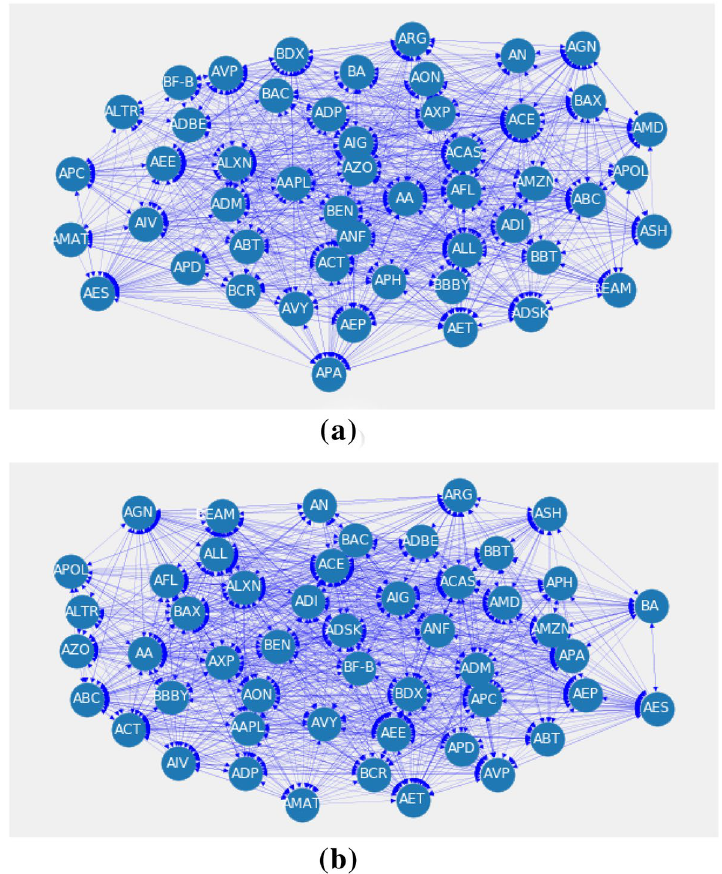
Figure 3. Visualization of directed network structure of 2008 for 50 stocks with: ( a ) Static threshold ( b ) Dynamic threshold. Here, we work on static threshold since it can identify financial crises properly. The higher indegree of a node imply the more influential company in the network. The names of the stock are given in appendix